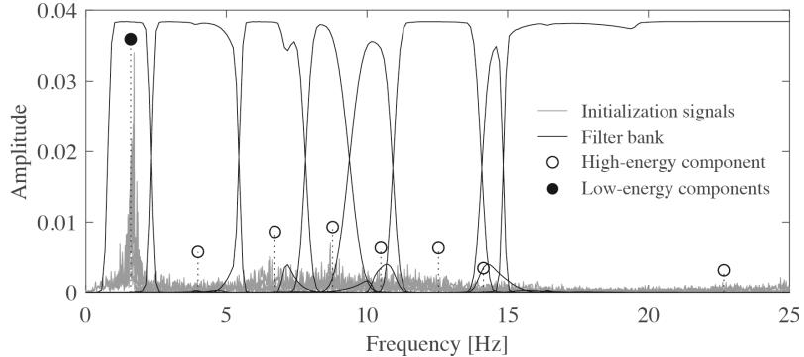
Figure 3. Filter bank for the extraction of the first modal response.